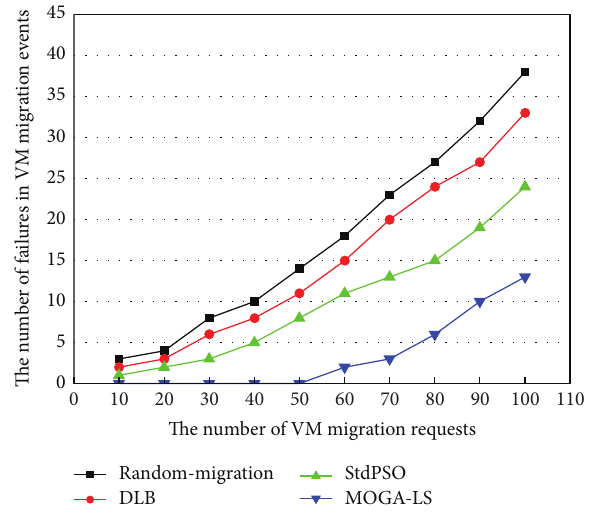
Figure 8: Comparison of the number of failures in VM migration events.